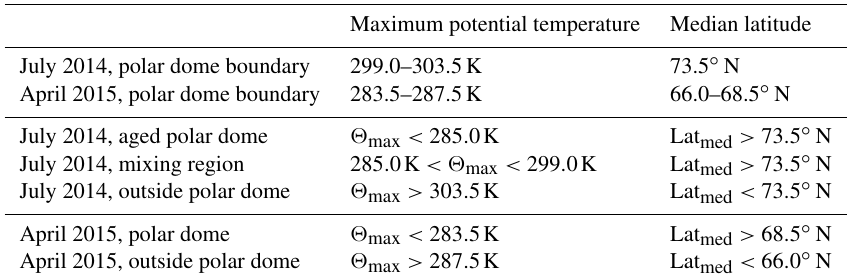
Figure 9. (a) Tracer–tracer scatter plot of all data points (background + pollution plumes) within the aged polar dome (blue), the mixing region (green), and outside the polar dome (red) for July 2014. (b) Tracer–tracer scatter plot of all data points (background + pollution plumes) within (blue) and outside (red) the polar dome for April 2015. To separate the different regions the tracer-derived polar dome boundaries are used. Boundary values for each region are summarized in Table 2. Table 2. Maximum potential temperature and median latitude values for the polar dome boundary. The boundary values used for separating the different regions identified for further analysis are also